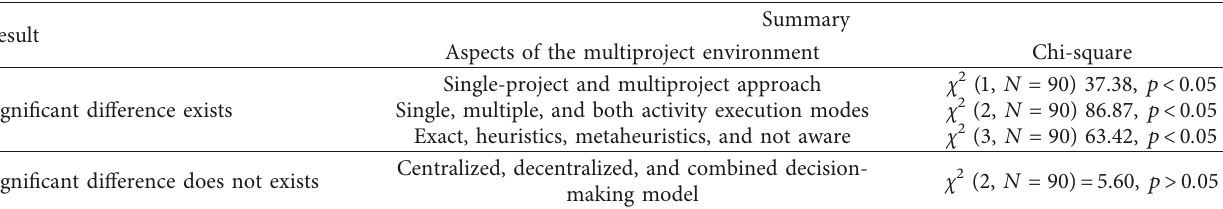
Table 10: Chi-square goodness of fit for the various aspects of the multiproject